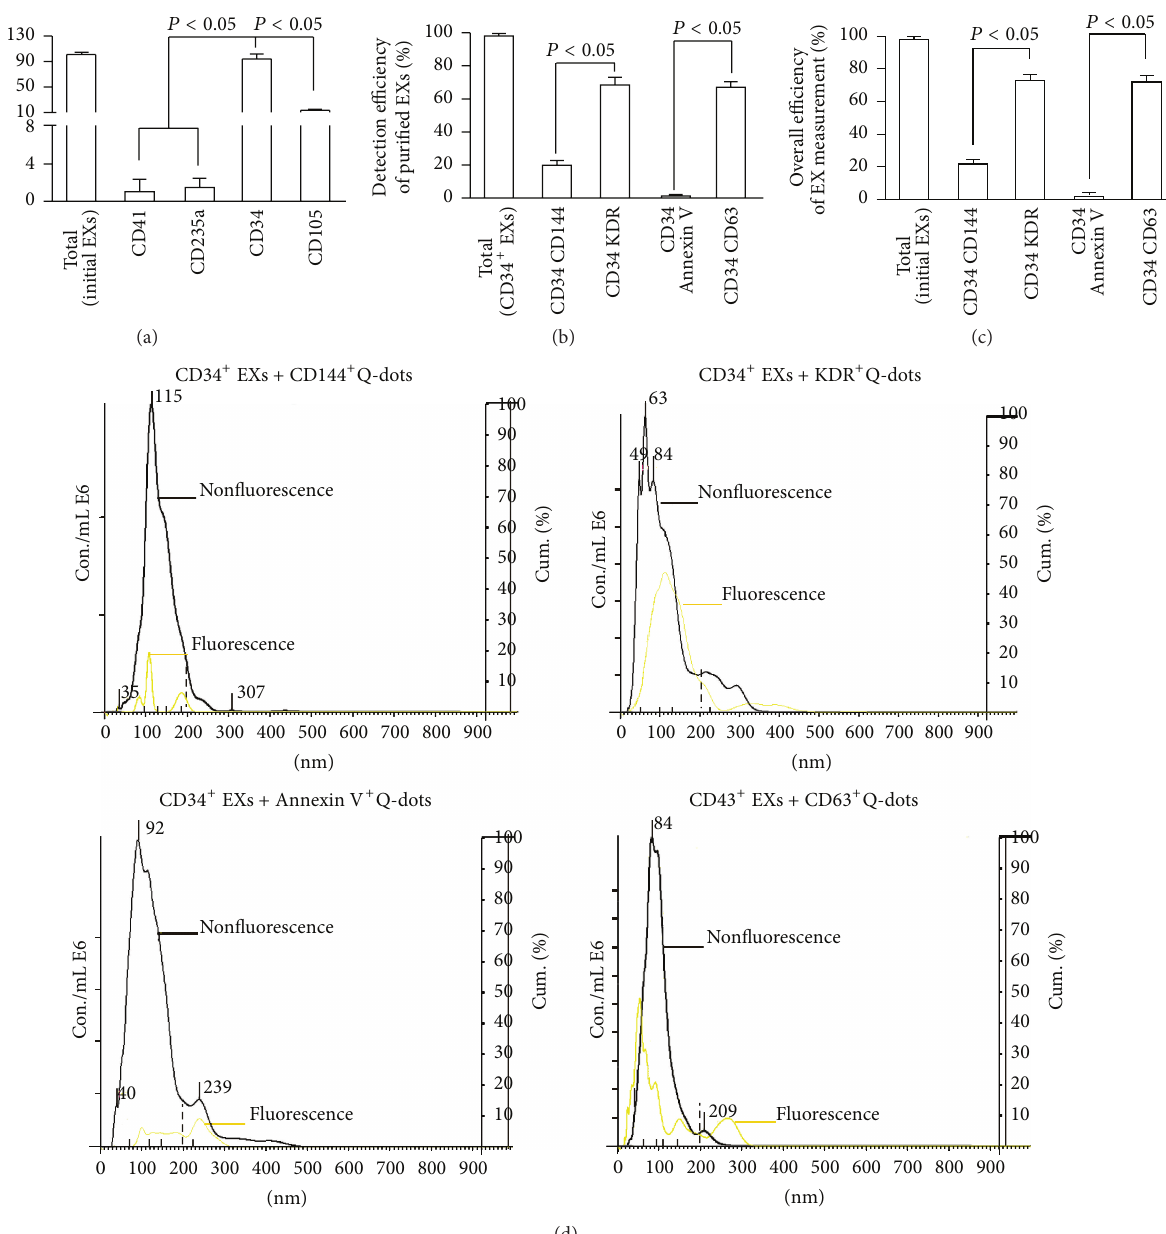
Figure 3: The efficiencies and specificities of the methods by combining microbeads with NTA for purifying and detecting EPC-EXs. (a) The purification efficiency and specificity of EPC-EXs in the total EPC-EXs, which were collected from EPC culture medium by ultracentrifuge andisolatedbyvariousmicrobeads-conjugatedantibodiesagainstEPCspecificmarkers(CD34,aswellasnegativecontrols,CD105,CD41,and CD235a). (b) The detection efficiency and specificity of EPC-EXs in the total CD34 + EXs that were labeled with CD144-, or KDR-, or Annexin V-, or CD63-conjugated Q-dots upon detection by fluorescence NTA. (c) The overall efficiency for measuring the CD34 + EXs colabeled with CD144-, or KDR-, or Annexin V-, or CD63-conjugated Q-dots in the total EC-EXs. (d) Representative plots showing the size/concentration distribution of the CD34 + beads isolated EXs under fluorescence/nonfluorescence modes. Black curve: CD34 + EXs measured under light scatter (nonfluorescence) mode. Yellow curve: CD34 + Q-dots + EXs measured under fluorescence mode. Black dash line: 200 nm landmark. 𝑁 = 4